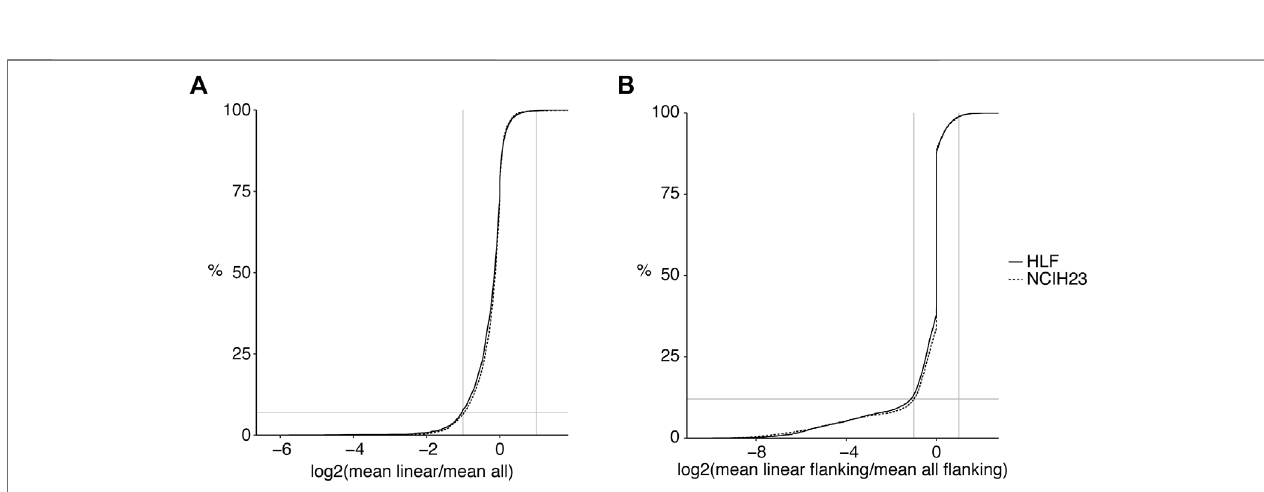
FIGURE 3 | Linear transcript counts can be overestimated in genes with circular transcripts. (A) Log2 fold changes of linear only reads per junction (CiLiQuant) compared to all forward-splice reads per junction (STAR mapping) for genes that have at least one back-splice junction (3,889 and 3,897 genes in HLF and NCIH23, respectively). Horizontal grey line: 8%; (B) At individual back-splice level, log2 fold changes of fl anking linear only reads per junction (CiLiQuant) compared to all fl anking forward-splice reads per junction (STAR mapping). Only backsplice junctions that have linear only fl anking junctions are shown (8,186 in HLF, 7,480 in NCIH23). Horizontal grey line: 12%. Vertical grey lines: absolute fold changes of